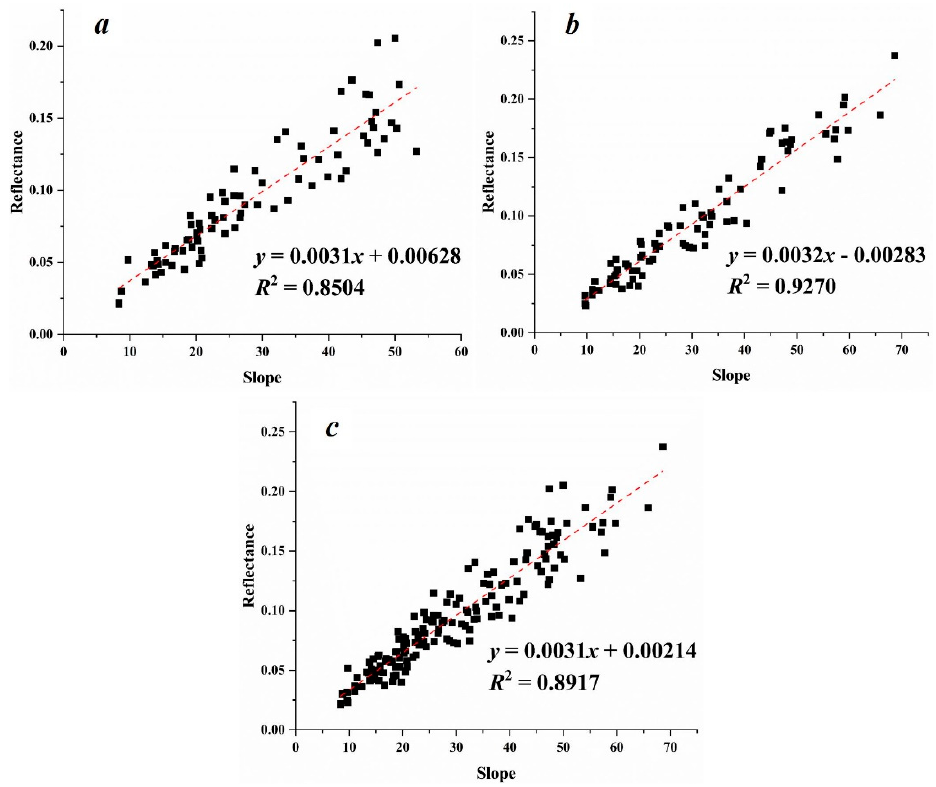
Figure 4. Scatterplot of RE’s reflectance and slope for tree species. ( a ) Only Pinus . ( b ) Only Larix . ( c ) Both species.